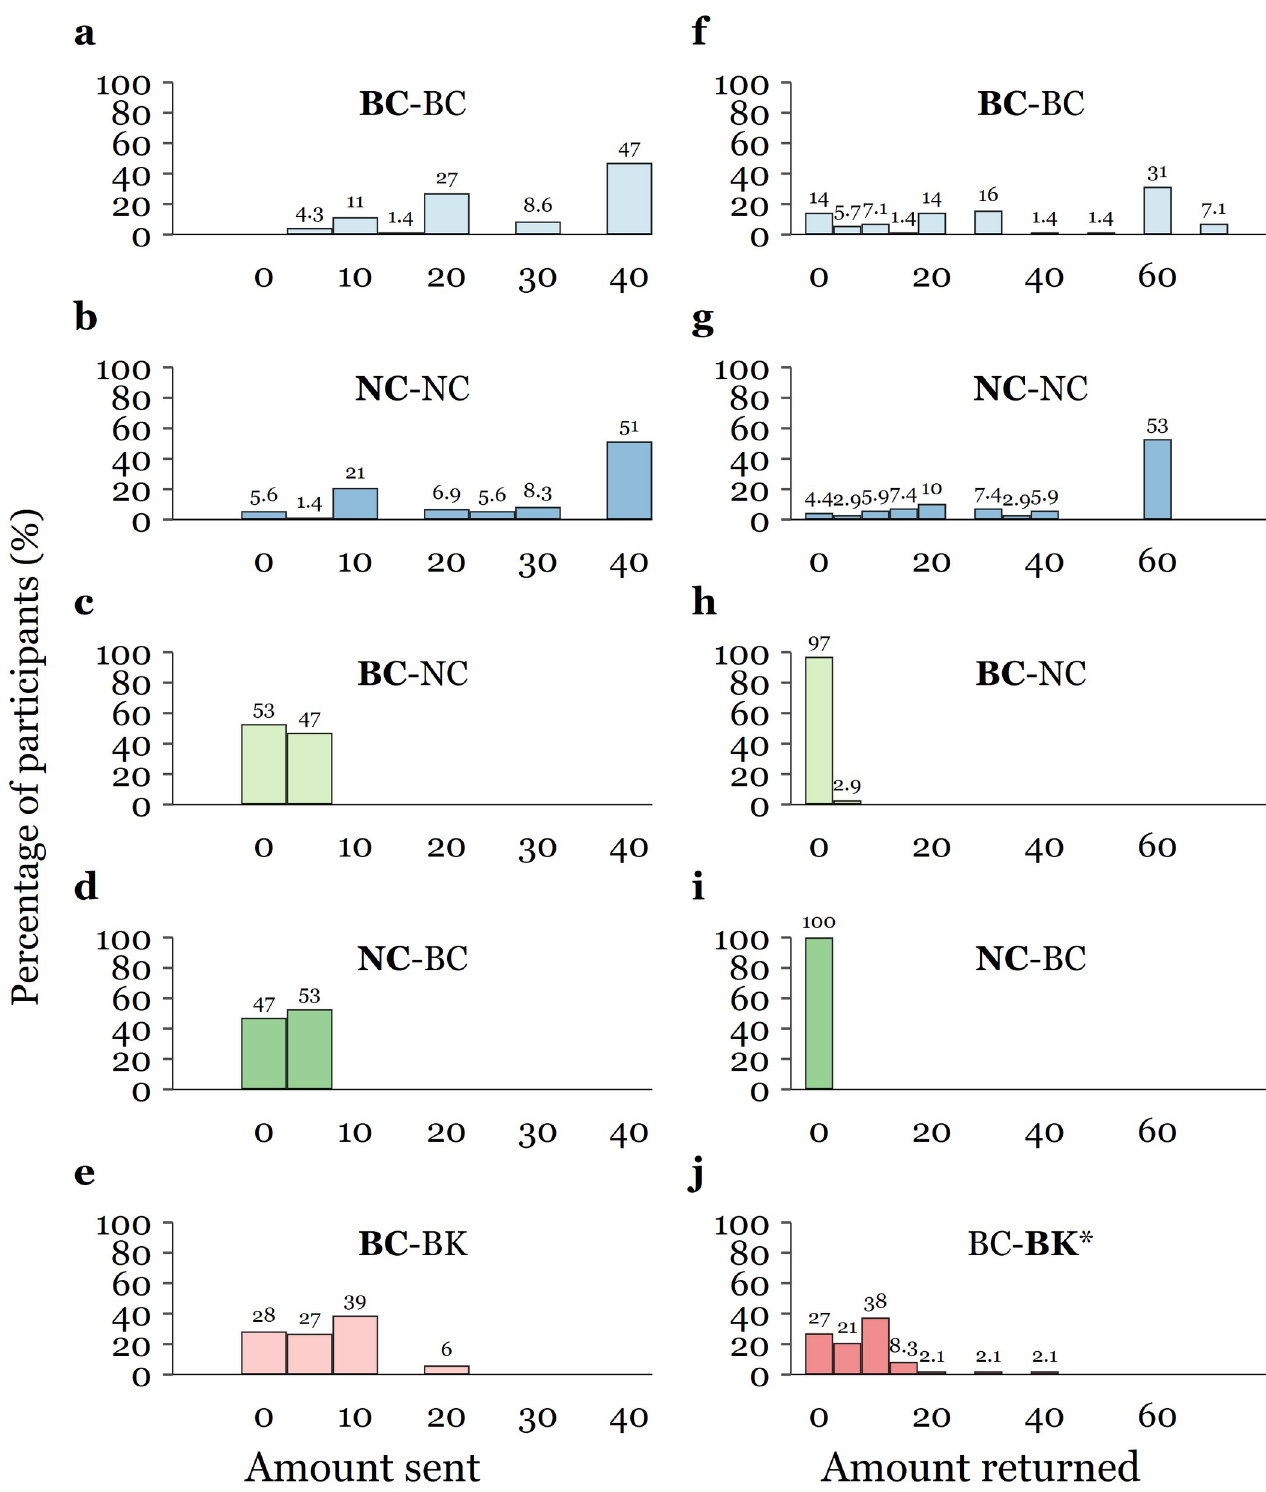
Fig 4. Distribution of amount offered and returned in the Trust Game, by treatment and session. Amount sent by Player 1 (panel a to e ) and returned by Player 2 given non-zero amount received (panel f to j ). � Amount sent back by Minh Khai students (BK).